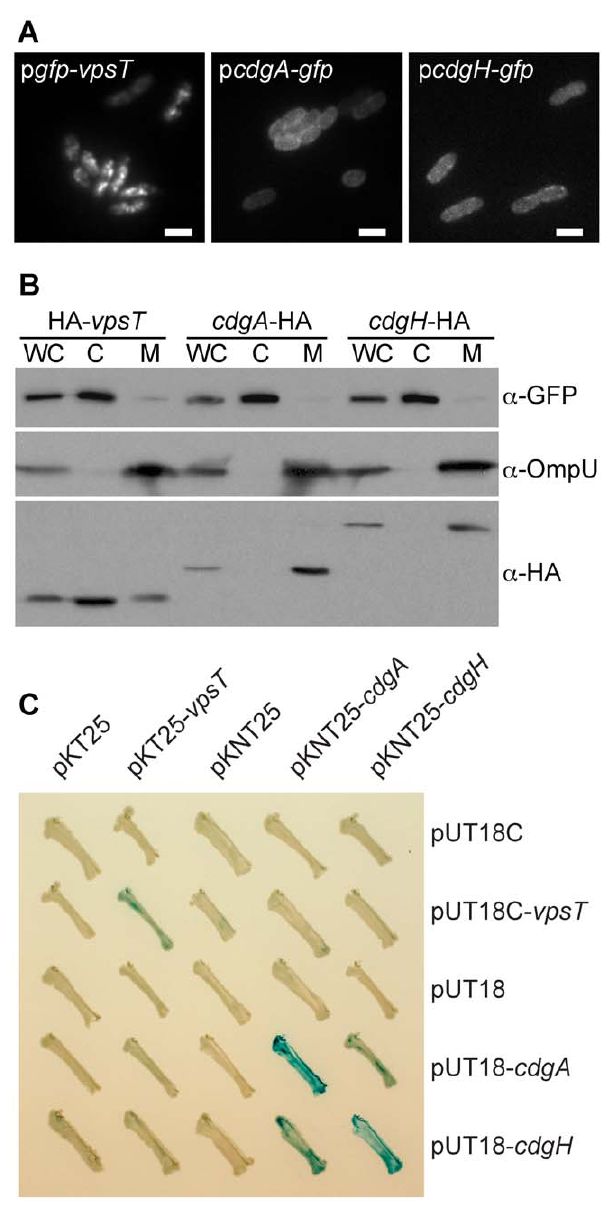
Figure 2. VpsT Does Not Interact with CdgA or CdgH Directly. (A) Representative epifluorescence micrographs of wild-type V. cholerae expressing GFP-VpsT, CdgA-GFP or CdgH-GFP fusion proteins. Marker is 2 m m. (B) Subcellular fractionation of V. cholerae strains containing vpsT , cdgA or cdgH tagged with an HA epitope in their native chromosomal loci. Western immunoblot was performed on cellular fractions representing whole cell (WC), cytoplasmic (C) and total membrane (M) fractions. HA-tagged proteins were detected using a polyclonal anti-HA antibody. gfp was constitutively expressed from a chromosomal locus. GFP was detected using monoclonal anti-GFP antibody and is used as a cytoplasmic fraction control. OmpU was detected using a polyclonal anti-OmpU antibody and is used as a total membrane fraction control. One representative experiment of three biological replicates is shown. (C) Bacterial two-hybrid analysis of VpsT, CdgA and CdgH. Reconstitution of CyaA, indicative of protein-protein interaction, was detected by b -galactosidase activity on LB plates containing ampicillin (100 m g/ml), kanamycin (50 m g/ml), IPTG (500 m M) and X-gal (40 m g/ml). Plates were incubated at 30 u C for 48